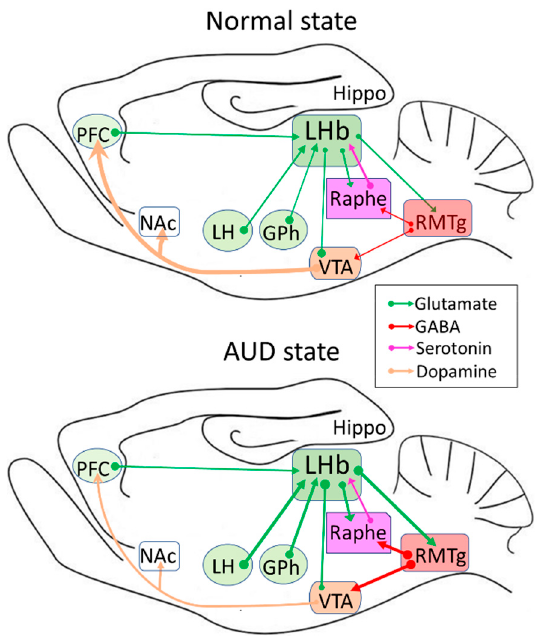
Figure 1. The brain network of the lateral habenula (LHb) in alcohol use disorders (AUDs) and its comorbidities. The LHb gets major inputs from the habenula-projecting globus pallidus (GPh), the prefrontal cortex (PFC), and the lateral hypothalamus (LH) and sends projections to dopamine neurons in the ventral tegmental area (VTA)/substantia nigra compacta (SNc) and serotonin neurons in the raphe directly or indirectly through the rostromedial tegmental nucleus (RMTg). The LHb also receives projections from the raphe. LHb’s spike output and glutamatergic transmission are increased in alcohol withdrawal rats and in animal models of depression, suggesting that the LHb plays a key role in AUDs and depressive disorders (DDs) and their comorbidities.